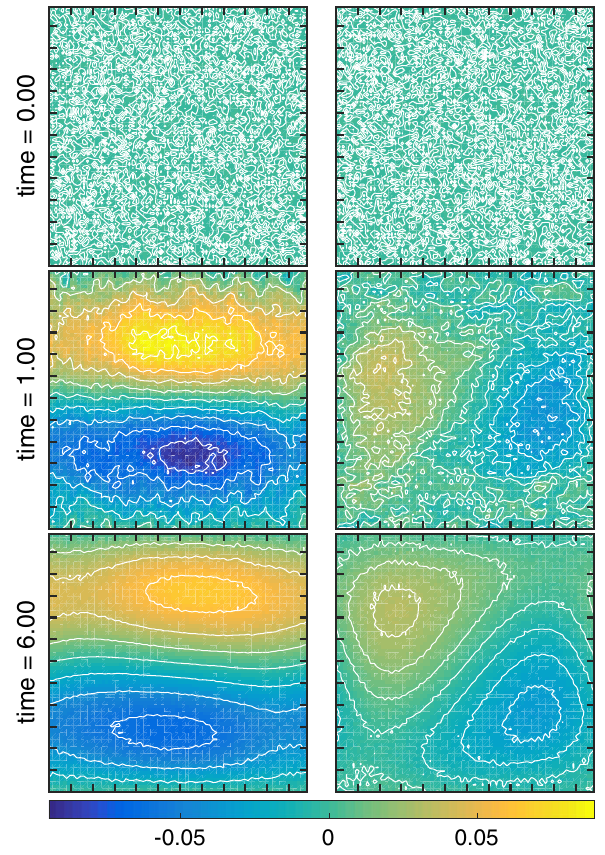
Fig. 2 Simulations of the fluid velocity components (left) v (right) v over a square domain of width 2 𝜋 on a 75 × 75 grid and 2 with periodic boundary conditions. These velocity simulations cor- respond to the h simulation in the left column of Fig. 1. Plots in the same row are simulated at the same time, and all plots are coloured according to the same colour bar (shown below the row of plots)